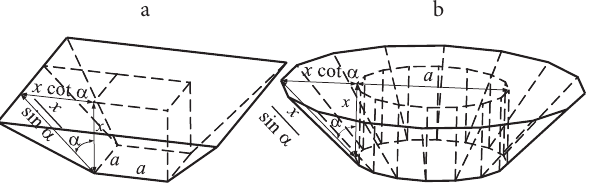
Fig. 5. Slab test diagram: 1 – RC slab; 2 – slab support contour; 3 – steel ties; 4 – hydraulic jack; 5 – force